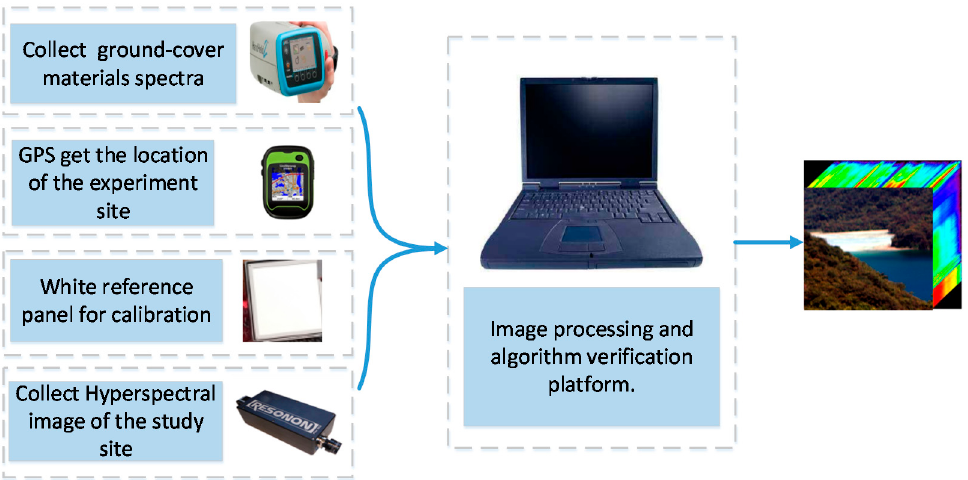
Figure 3. System of data acquisition.